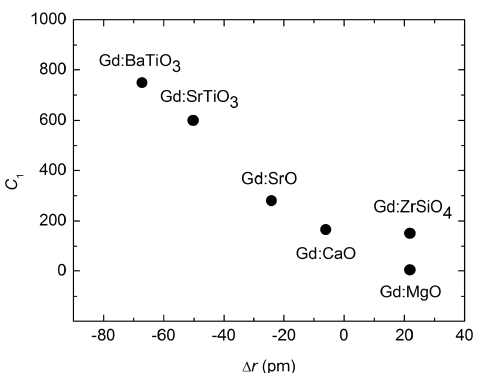
Figure 4. Dependence of the coefficient C Δ r = r